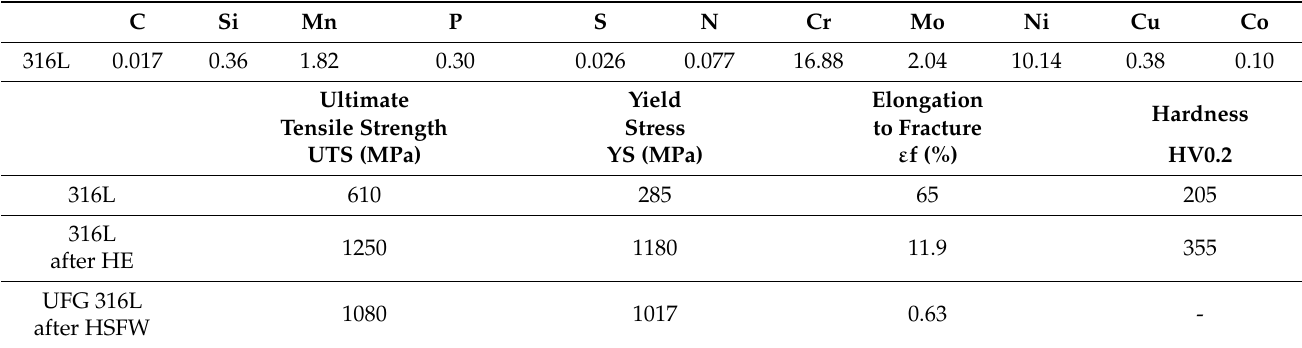
Table 1. Chemical composition (wt.%) of the examined stainless steel (manufacturer specification) and mechanical properties before and after HE.